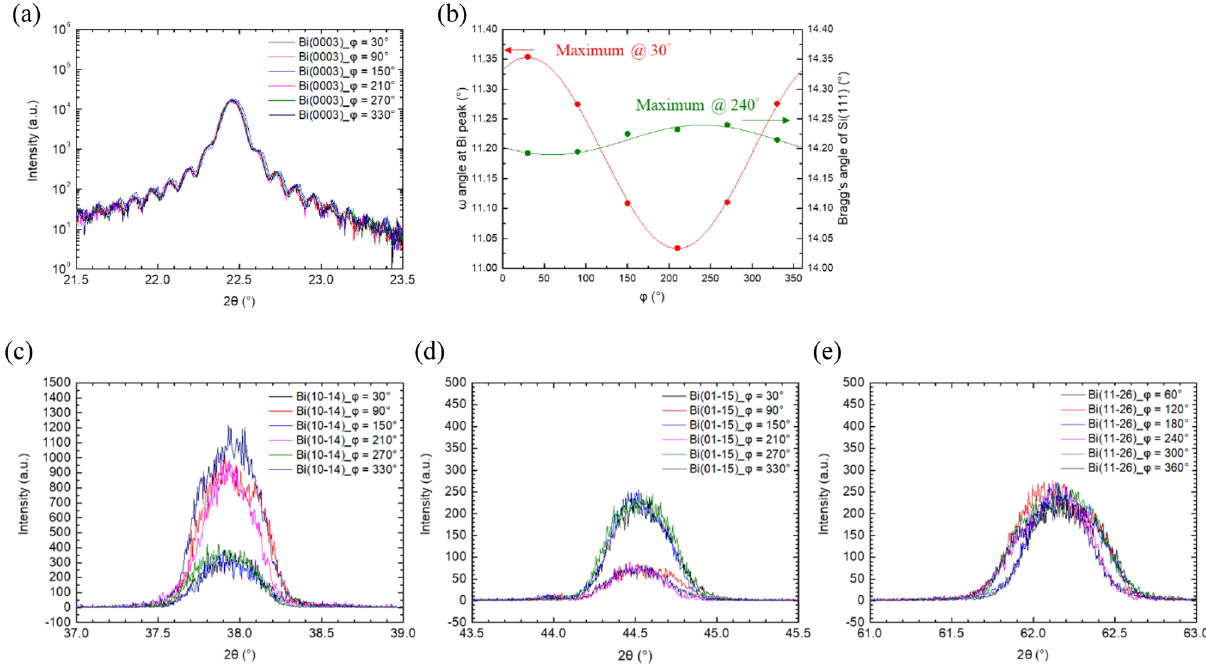
Figure 4. ( a ) HRXRD ω-2θ scans of Bi (0003) at six different φ angles. ( b ) The oscillation behavior of Bi (0003) ω-angles and Si (111) Bragg’s angle for different φ angles. ω-2θ scans of asymmetric ( c ) Bi (01-14), ( d ) Bi (10-15), ( e ) Bi (11–26) planes are also performed at six different φ angles.